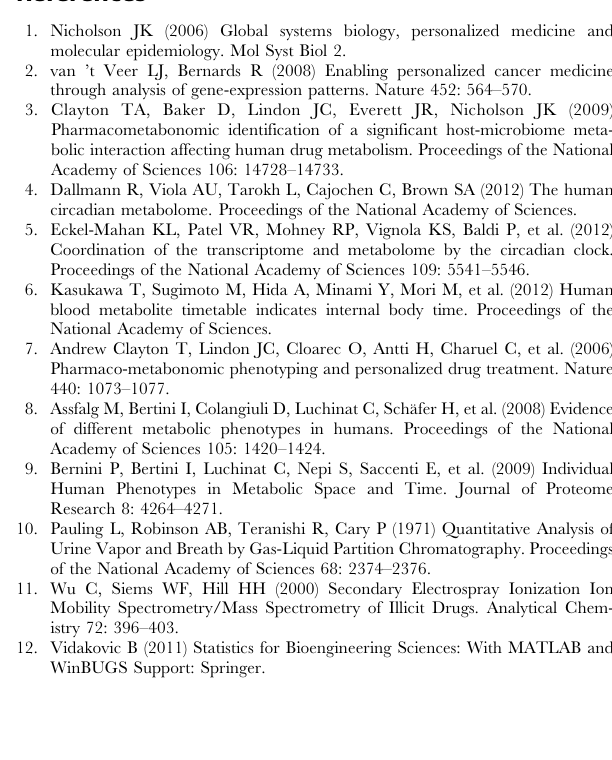
Table S1 Characteristics of this study subjects. Table S2 Mean signal intensities and 95% confidence interval for the mean (in parentheses) for the most diagnostic ions (i.e. higher absolute global loading coefficients). The p-values